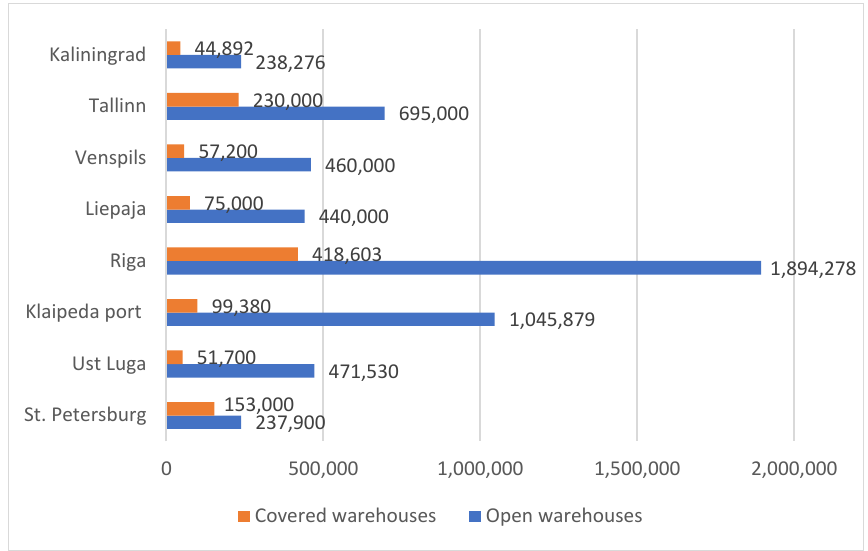
Figure 17. Cargo storage.